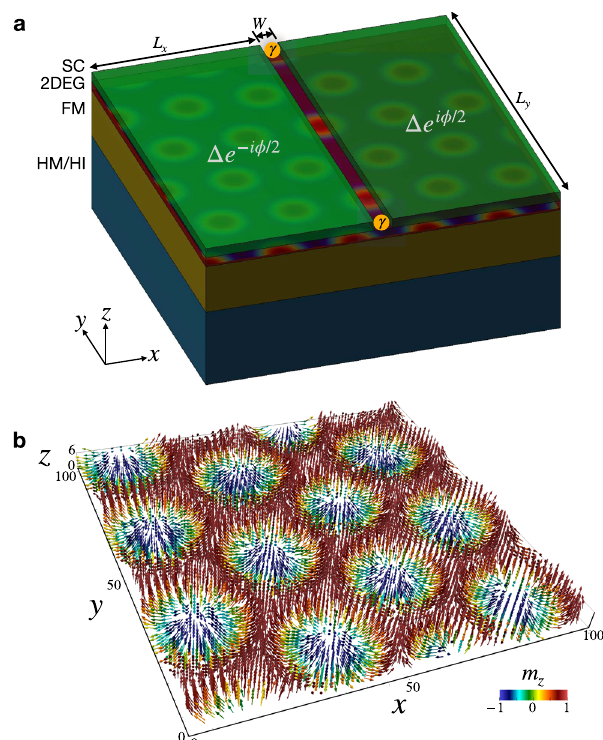
Fig. 1 Device geometry and a skyrmion crystal. a Planar Josephson junction on top of a skyrmion crystal. The two-dimensional electron gas (2DEG) exhibits both proximity-induced superconductivity from the top superconductor (SC) layers and spatially varying magnetism from the bottom skyrmion crystal that is created in the ferromagnet due to the competition between exchange interactions in the ferromagnet (FM) and the heavy metal or heavy insulator (HM/HI), with a fi eld or anisotropy. The zero-energy Majorana bound states (shown as yellow bubbles) are localized at the two ends of the quasi-one-dimensional metallic channel. b The skyrmion crystal spin texture, spontaneously generated in a Monte Carlo simulation using a 100 × 100 × 6 lattice with ferromagnetic exchange interaction strength J = 1, Dzyaloshinskii-Moriya interaction strength D = 0.3 J , magnetic fi eld H = 0.1 J , spin amplitude S = 1, and easy-plane z anisotropy A = 0.01 J . The colorbar in b denotes the z component of the magnetization m z